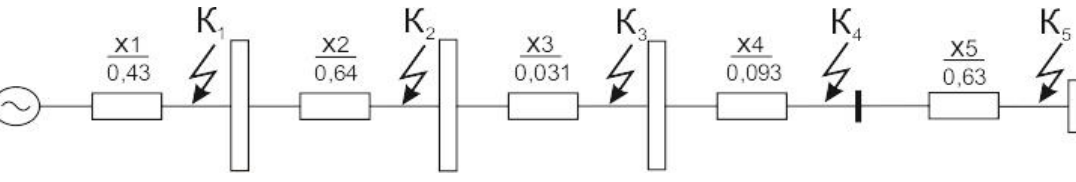
Figure 1 . The equivalent circuit of part transmission grid 6 kV at underground